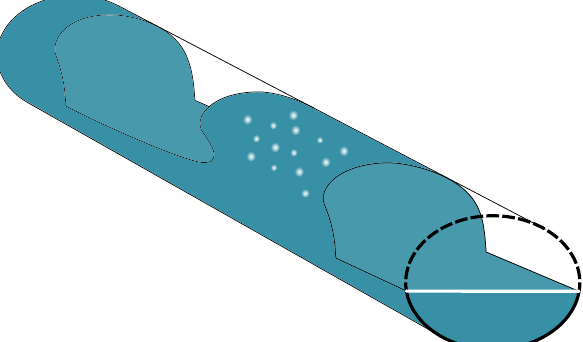
Figure 1. Slug flow. Gas bubbles are separated by liquid slugs. At the near end of the pipe, we have illustrated the gas–wall perimeter S g (black dashed line), liquid–wall perimeter S l (black line) and the interface perimeter S i (white